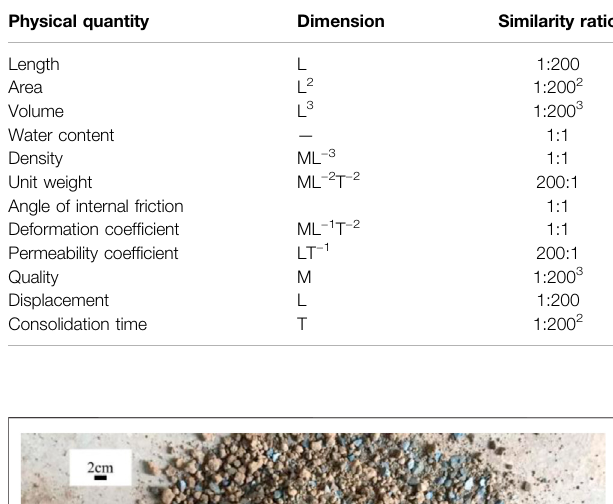
TABLE 2 | Material mechanical parameters of sericite quartz schist.